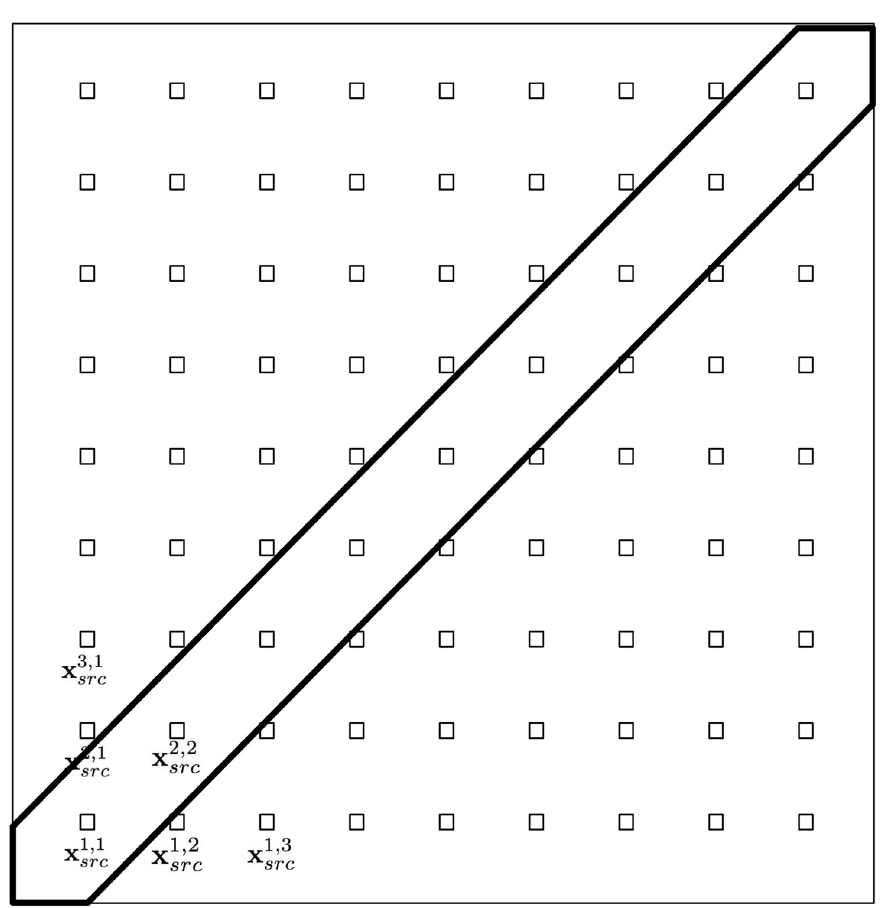
Fig 2. Numerical domain A = [ − 1, 1] × [ − 1, 1] with a diagonal strip where the diffusion coefficient is bigger according to Eq (2).